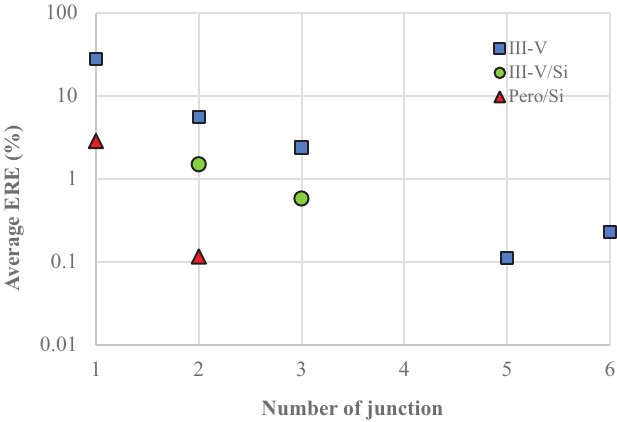
Fig. 6. Changes in average external radiative ef fi ciency ERE for III – V multi-junction, III – V/Si tandem solar cells and perovskite/ Si tandem solar cells as a function of number